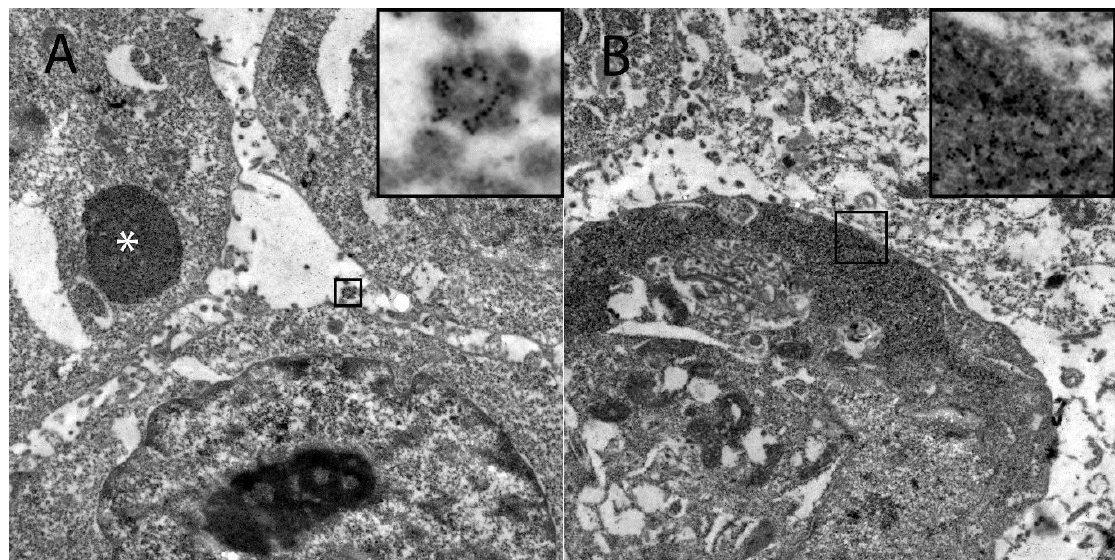
Figure 5. Demonstration of the intracellular HIF-1 α localization in persistently canine distemper virus infected DH82 cells as determined by immunoelectron microscopy. ( A ) HIF-1 α was found within variably sized, round, moderately to highly electrondense vesicles (insert) and in large moderately electrondense vacuoles (*). Additionally, HIF-1 α was detected often in the sub-membranous area of the cytoplasm (insert; B ). Magnification 9000 × .